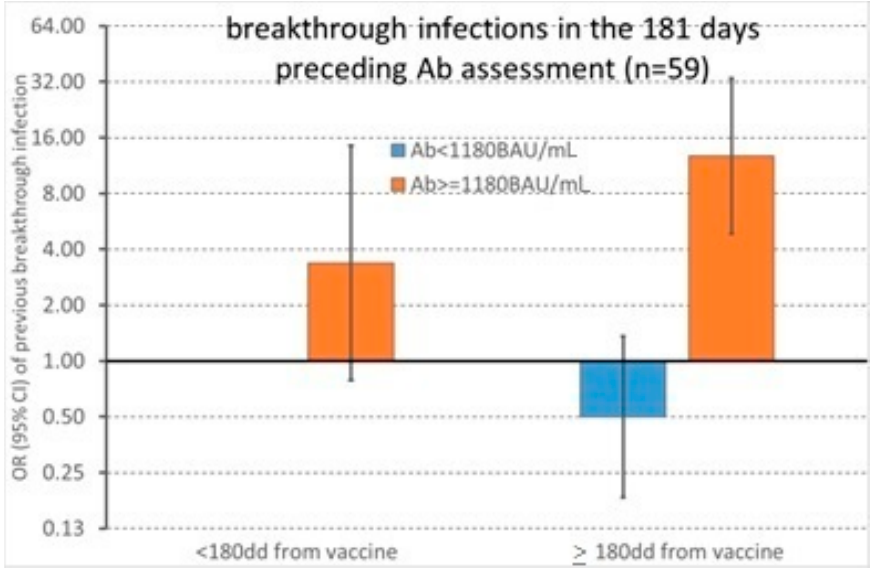
Figure 2. Discriminant power of antibody-S IgG titer evaluated by area under the ROC curve (ROC- AUC), as a function of time elapsed since second vaccination dose.